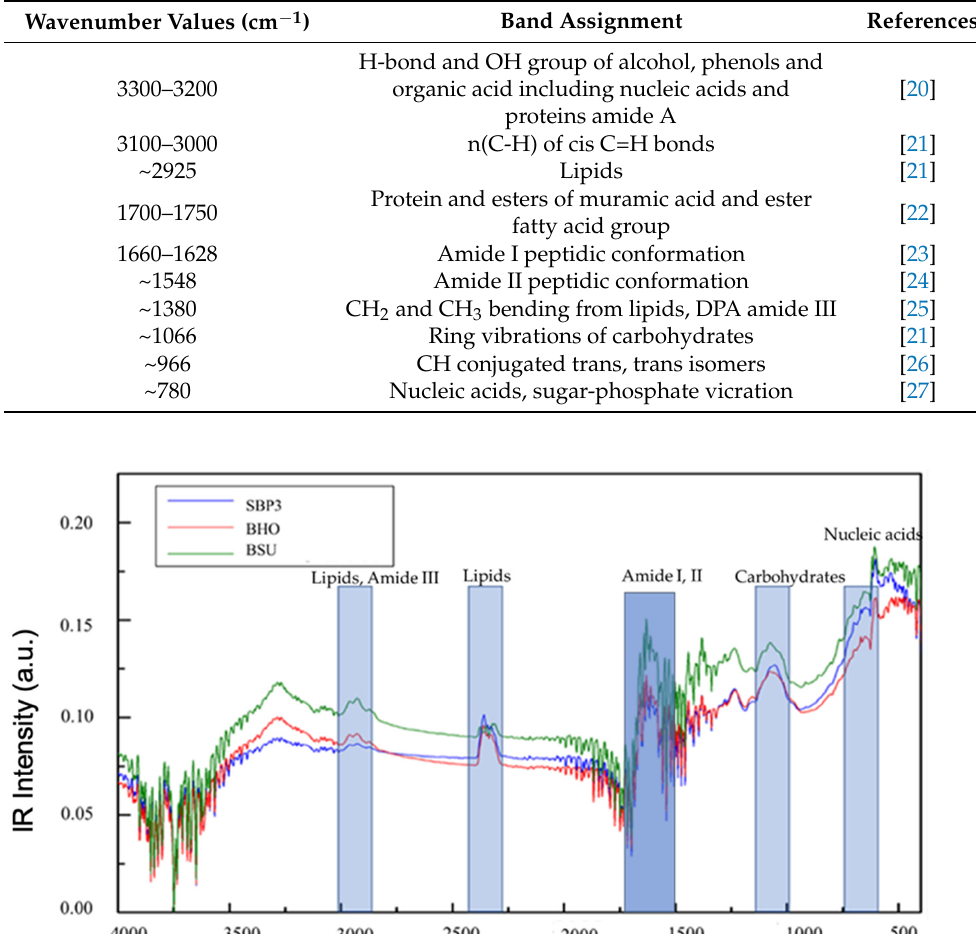
Table 1. FTIR band assignments for the functional groups according to Vongsvivut et al. [19].